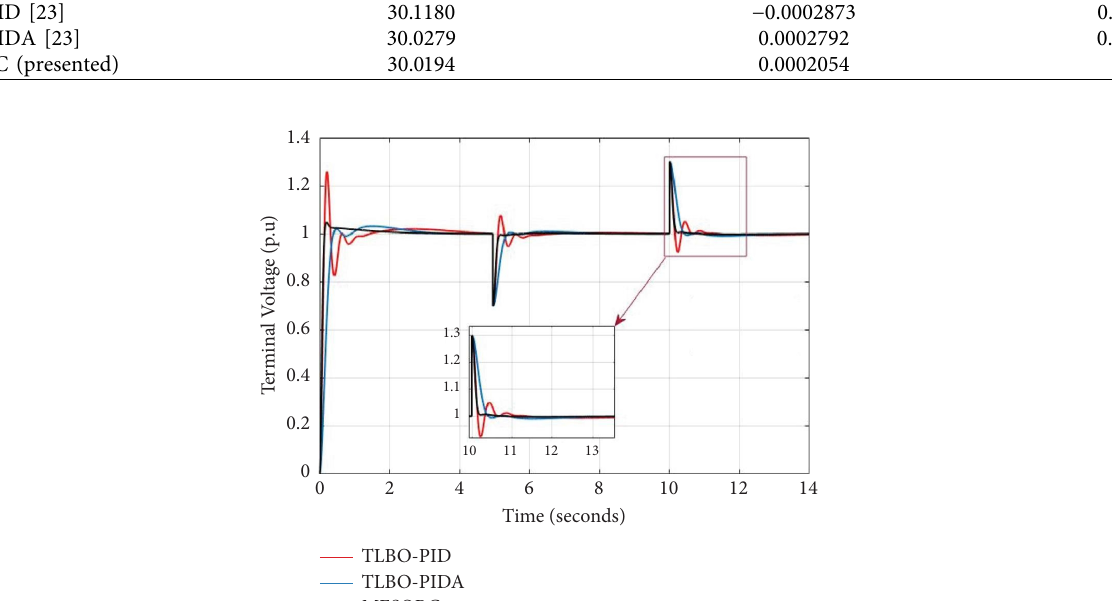
K g and g ) and ± 30% load voltage variation.